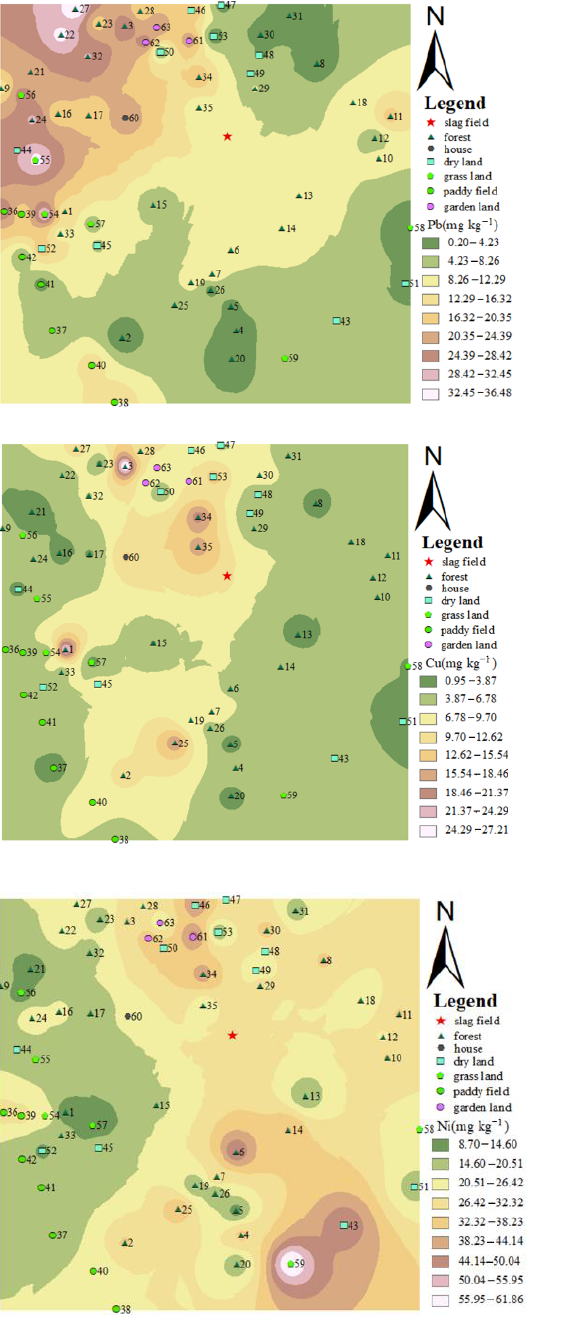
Figure 2. Spatial distribution of heavy metals in soil.